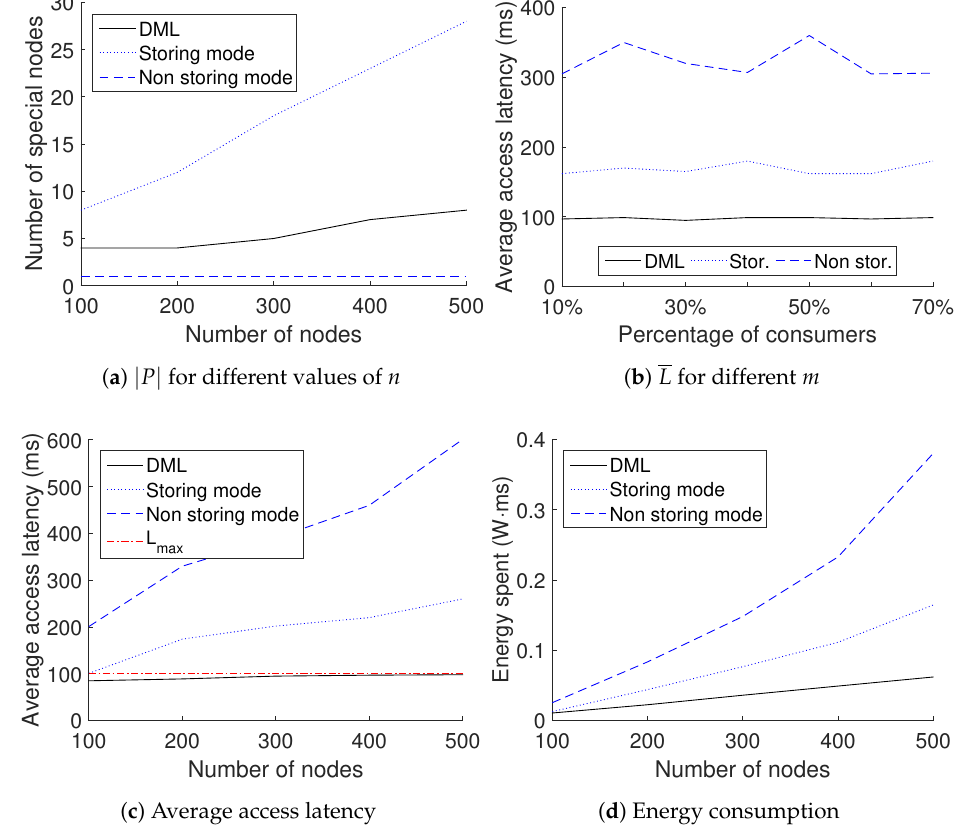
Figure 8. Comparison of the three